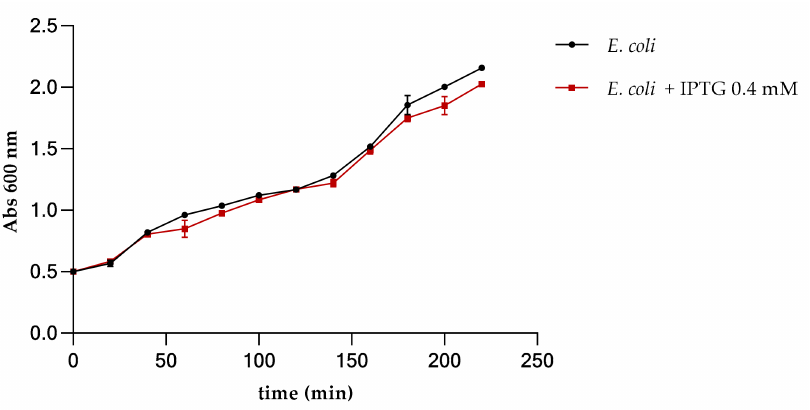
Figure 2. Growth curve of E. coli BL 21 in the presence and in the absence of IPTG 0.4 mM for the over expression of GST-peptide. The error bars on the graphs stand for the standard deviation from the mean of three experiments.